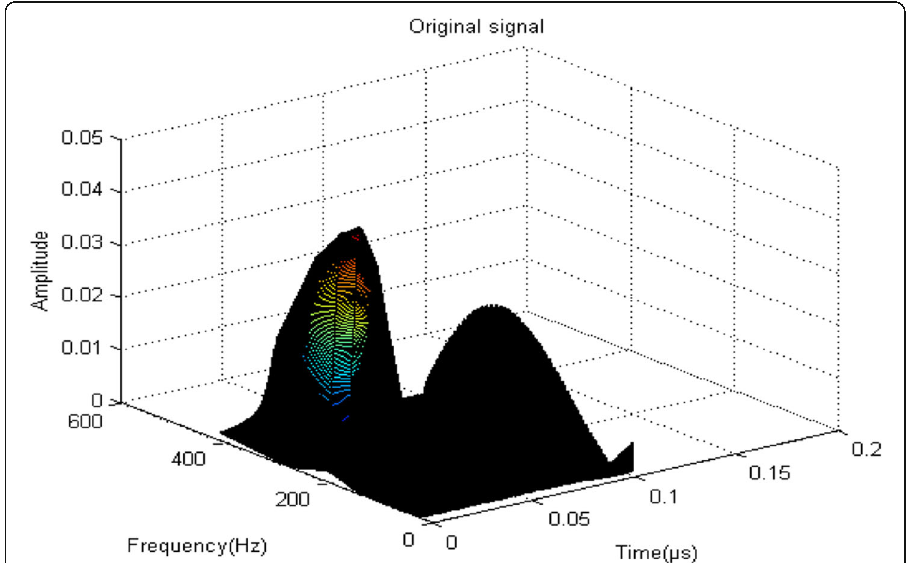
Fig. 5 Time-frequency diagram of original simulation